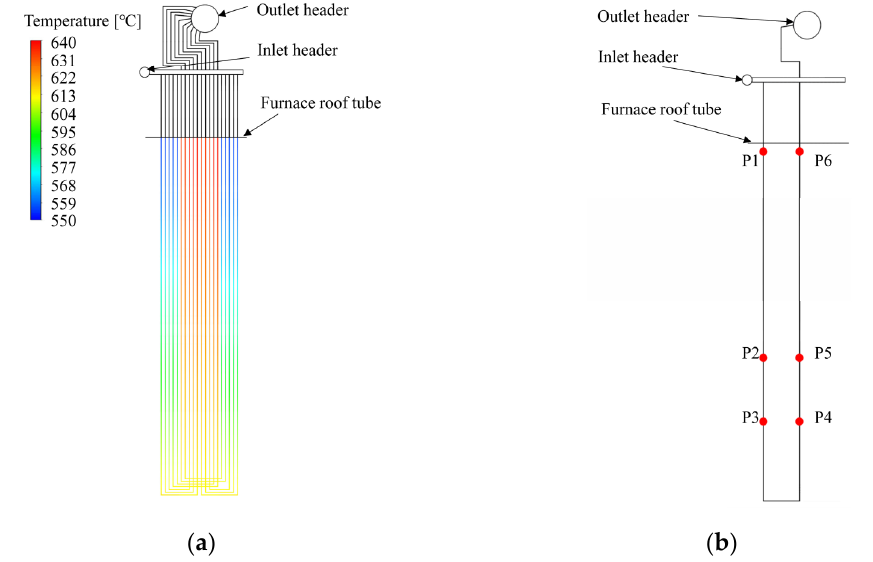
Figure 11. Calculation results of the temperature distribution of serpentine and feature points locations; ( a ) tube wall temperature distribution of serpentine; ( b ) locations of P1 to P6. The wall temperatures of the six feature points (Ttw-P1 to Ttw-P6) on the 50th tube platen of the FSH operating at 100 and 75% load cases are shown in Figure 12. The temperature variation trends under the two load cases were different. For the 100% load case, the tube wall temperature rose in a zigzag manner from P1 to P6. The phase in which the tube wall temperature rose was most pronounced between P3 and P4. This is not only related to the long tube distance here, but also related to the local thermal deviation con- dition, i.e., the high local flue gas temperature. For the 75% load case, the local high tem- perature zone at the inlet of the FSH moved up, and the wall temperature increased almost linearly from P1 to P6. Compared to the 100% load case, the wall temperature rose from P3 to P4 decreased for the 75% load case, while from P2 to P3 and from P4 to P5, it in- creased. The tube wall temperature after P3 for the 75% load case was higher than that for the 100% load case, and the difference between them was about 8 °C at P6, where the tube wall temperature reached its highest value.